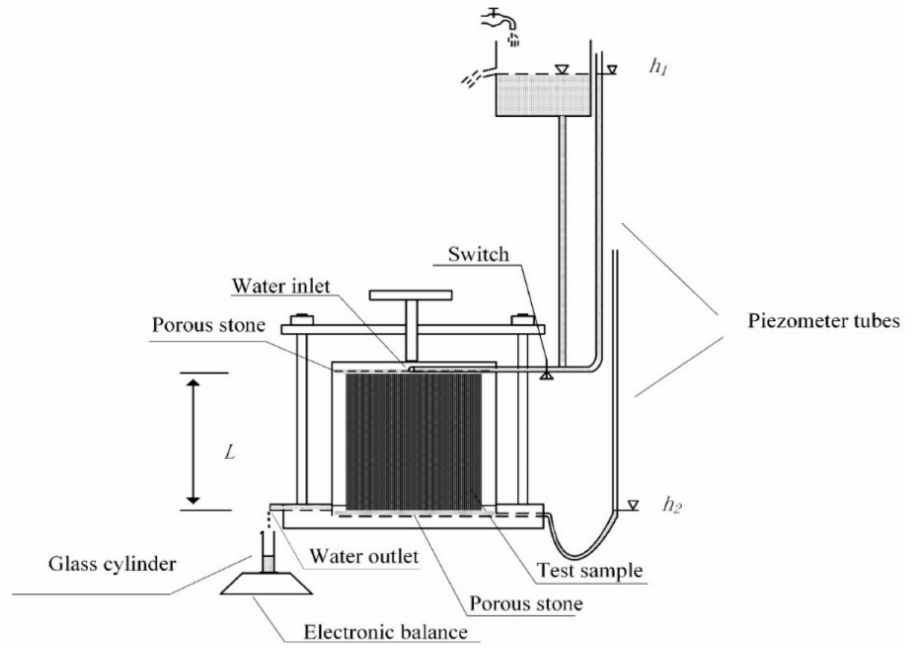
Figure 2. Schematic diagram of the experimental setup. The outflow water was collected in a glass cylinder and weighed using an electronic balance under the glass cylinder.